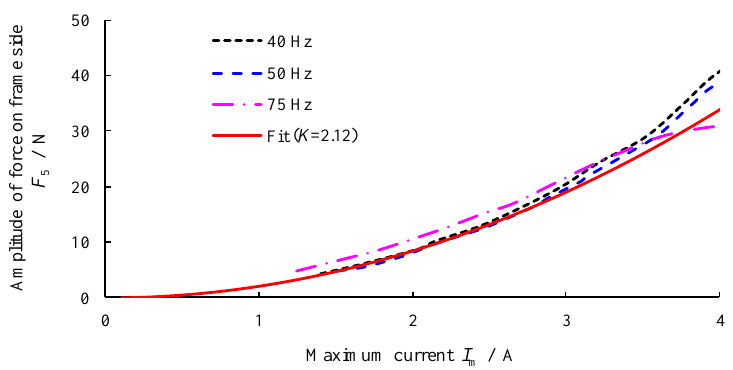
Figure 9. Experimental results and the fitted curve for F 5 ~ I m,a .